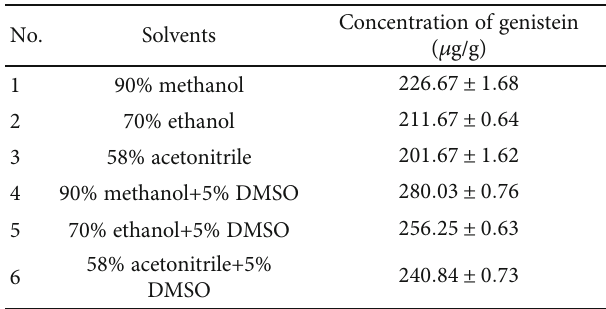
Table 1: Concentration of genistein in Cuminum cyminum extracted under di ff erent